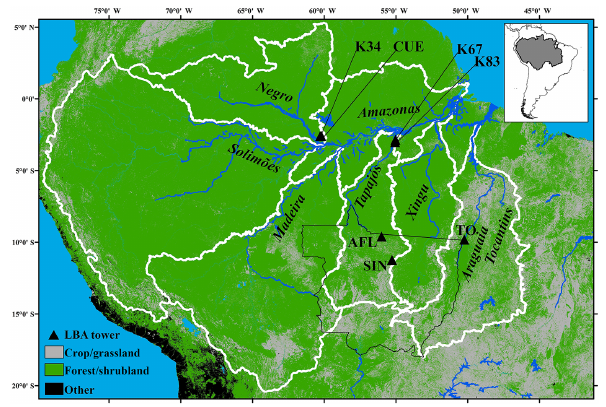
Figure 1. The Amazon Basin of South America with its main river basins (ANA, 2015), eddy covariance tower network from the Large-Scale Biosphere-Atmosphere Project in Amazonia (Ta- ble 2) (Keller et al., 2004) and aggregated land uses as classified by the ESA GlobCover 2009 Project (ESA, 2010; © ESA 2010 and UCLouvain), and the political divide of the Brazilian state of Mato Grosso at the agricultural frontier of south-eastern